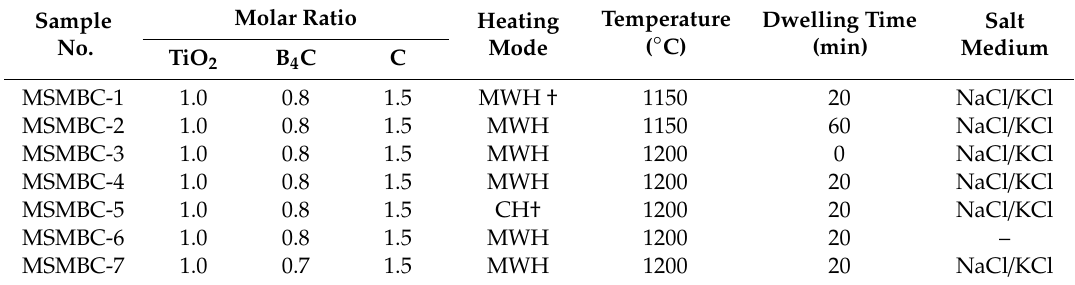
Table 1. Batch Compositions and Processing Parameters for Manufacturing TiB 2 Powders by the MSM-BCTR